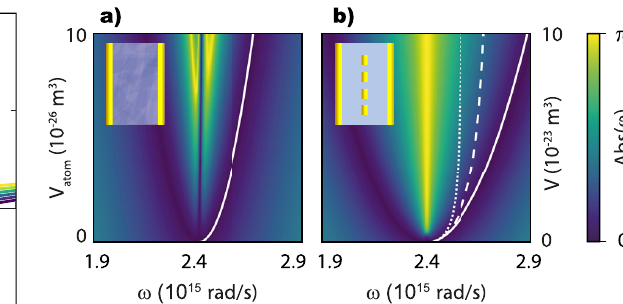
(cid:15)(cid:15)(cid:15)(cid:15) (cid:15)(cid:15)(cid:15)(cid:15) φ with φ de fi ned from equating the Figure 10: Color plots of resonant denominator of Eq. (22) to − 1 + Ae i φ , as a function of oscillator strength and frequency, for fi xed etalon opening chosen such that the bare etalon has its resonance frequency at the resonance ω 0 (cid:1) 2 . 4 ⋅ 10 15 s − 1 of the inserted dispersive medium (panel a) resp. metasurface (panel b). The white parabola in (a) over plots Eq. (24). Also for the resonant metasurface case, the splitting traces a parabola (white continuous line, Eq. (23). This is surprising, as this prediction takes the static polarizability as input, whereas the dynamic and lattice polarizabilities that determine the single- particle resp. collective antenna scattering strength are strongly different. Dashed and dotted lines show the Rabi splitting if one would have to correct V in Eq. (23) with the on-resonance dynamical resp. lattice radiative correction factor (see Eq. (25)). Parameters as in Figure